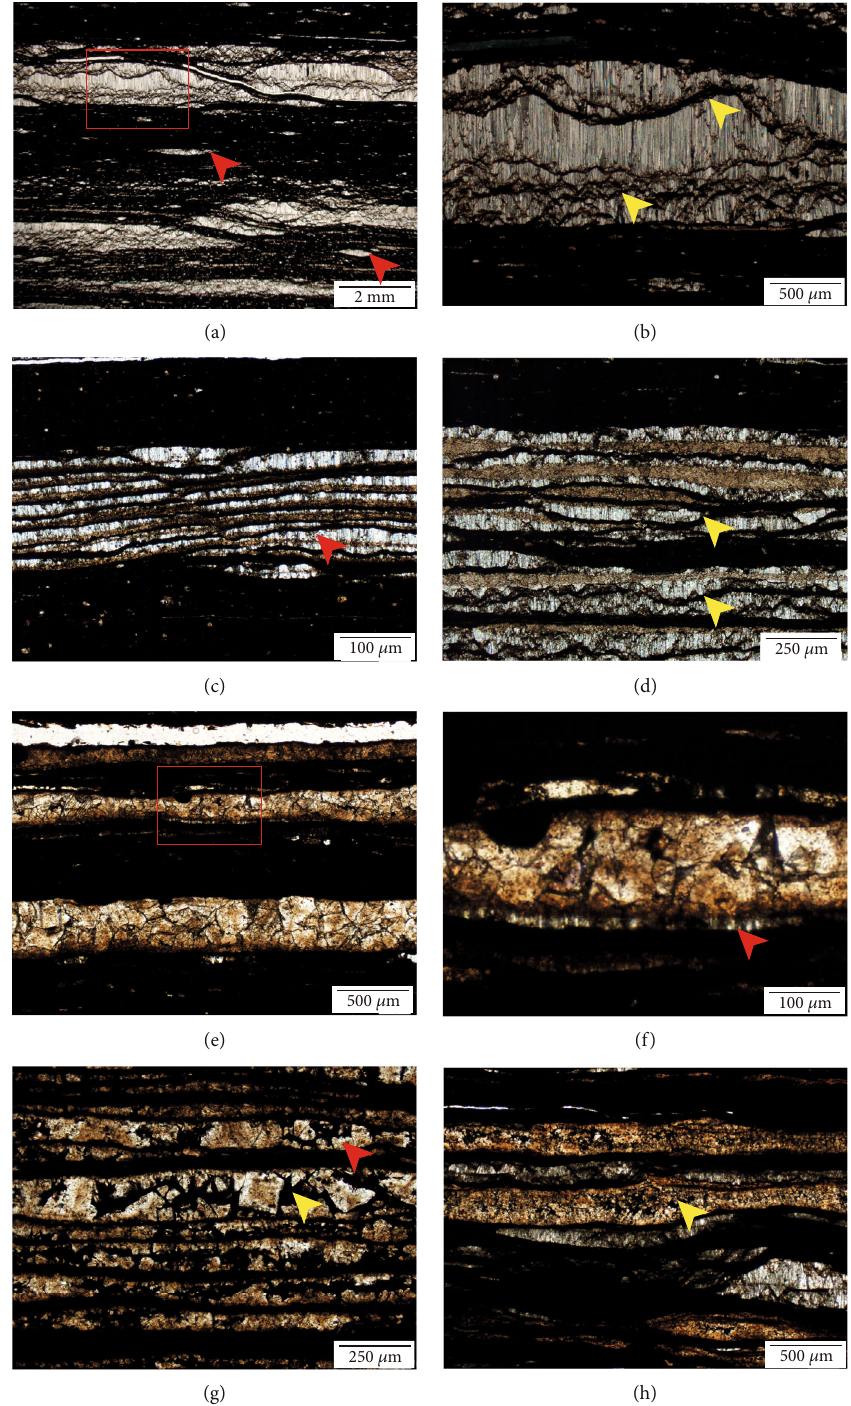
Figure 6: Calcite veins seen under a microscope. (a) FY1, 3197.27m: a calcite vein with fi brous crystals, with many small calcite lenses (red arrows) possibly growing in host rock and solid inclusions (yellow arrows) arranged in a sinusoidal manner and as inclusion trails. (b) The red outline of (a). (c) NY1, 3414.23m: sample shows coexistent initial micritic carbonate and fi brous calcite. Fibrous calcite grows on the fl anks of micritic carbonate (red arrow). (d) FY1, 3438.52m: the sample is similar to sample (c) with abundant solid inclusions (yellow arrows). (e) NY1, 3458.57m: calcite veins consisting of blocky crystals with single crystals about 100 μ m. (f) The red outline of (e), in which fi brous calcite are seen near the blocky crystals (less than 40 μ m, red arrow). (g) FY1, 3418.35 m: the calcite veins consist of blocky crystals (red arrow), but the sizes of the single crystals are obviously di ff erent, with solid inclusions (yellow arrow) fi lled between these crystals. (h) FY1, 3418.47m: fi brous calcite veins and coarse-grained carbonate veins grow together. The dark materials are fi lled between the coarse- grained carbonates (yellow